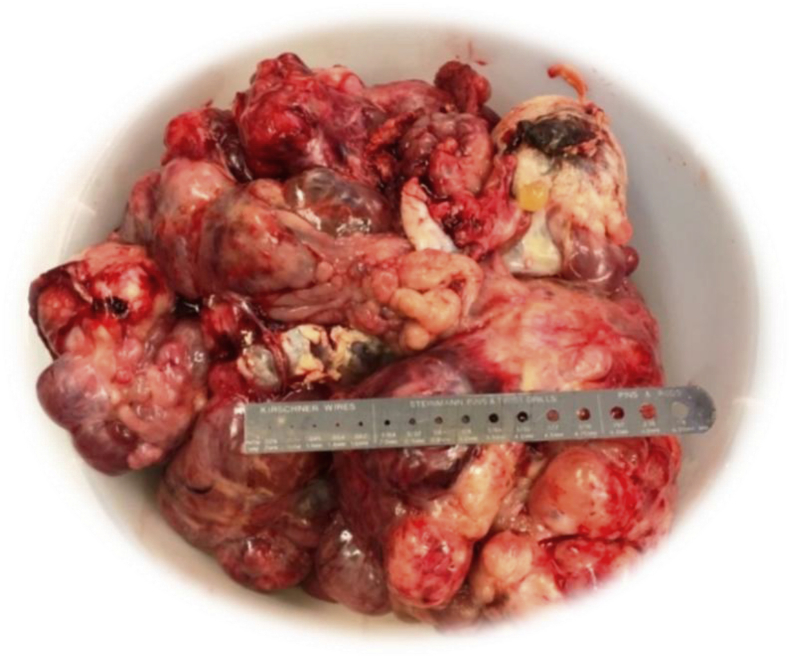
Operative specimen.